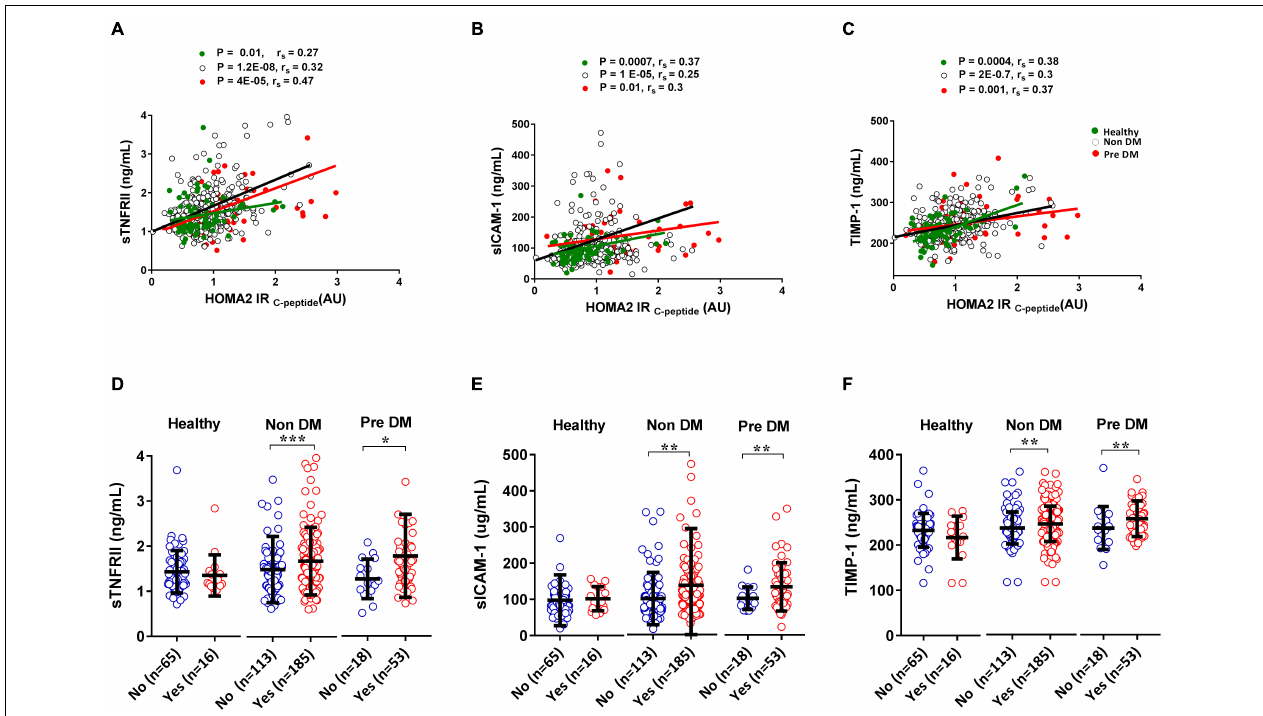
FIGURE 4 | Correlation and association of inflammatory markers with insulin resistance and metabolic syndrome. Inflammatory molecules correlate with an increase in the level of insulin resistance. The green dot indicates Healthy, black circles indicate Non-DM and red dots indicate Pre DM individuals, r indicates Spearman’s rho (A–C) . Individuals having metabolic syndrome have a higher level of inflammatory biomarkers (D–F) . P -values were calculated using non-parametric Mann–Whitney U -test for comparing between two groups and spearman correlation test was used to correlate inflammatory molecule with insulin resistance (ns P > 0.05, ∗ P < 0.05, ∗∗ P < 0.01, ∗∗∗ P <